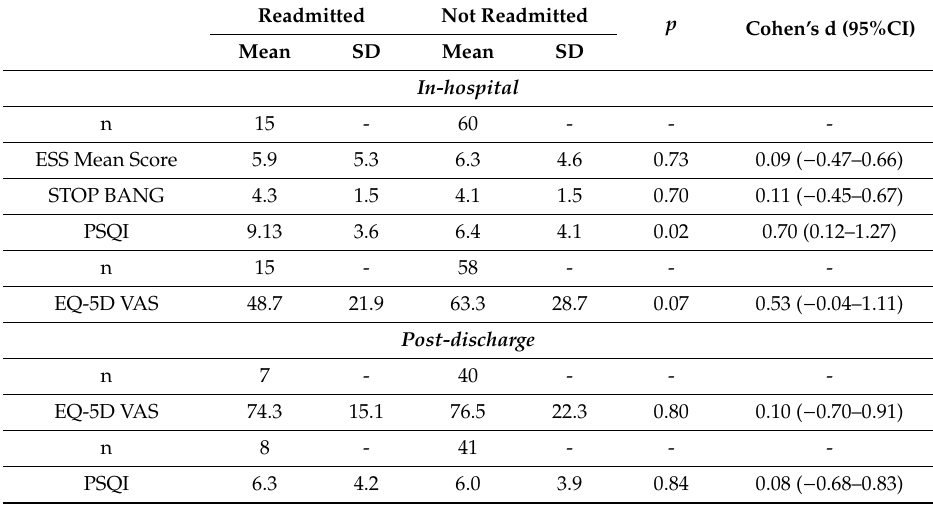
Cohen’s d (95%CI)